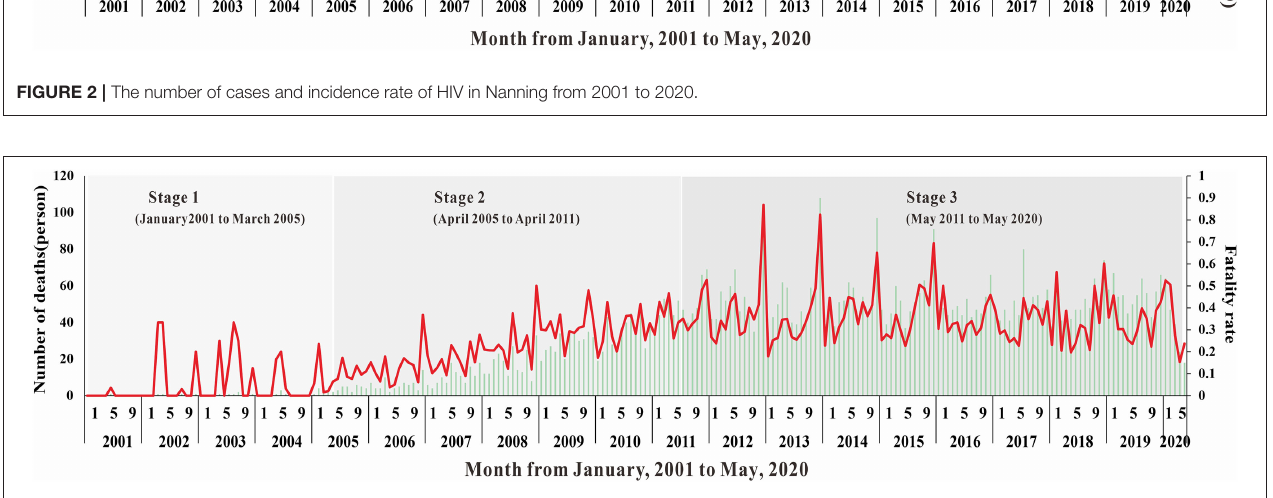
FIGURE 3 | The number of deaths and fatality rate of HIV in Nanning for twenty